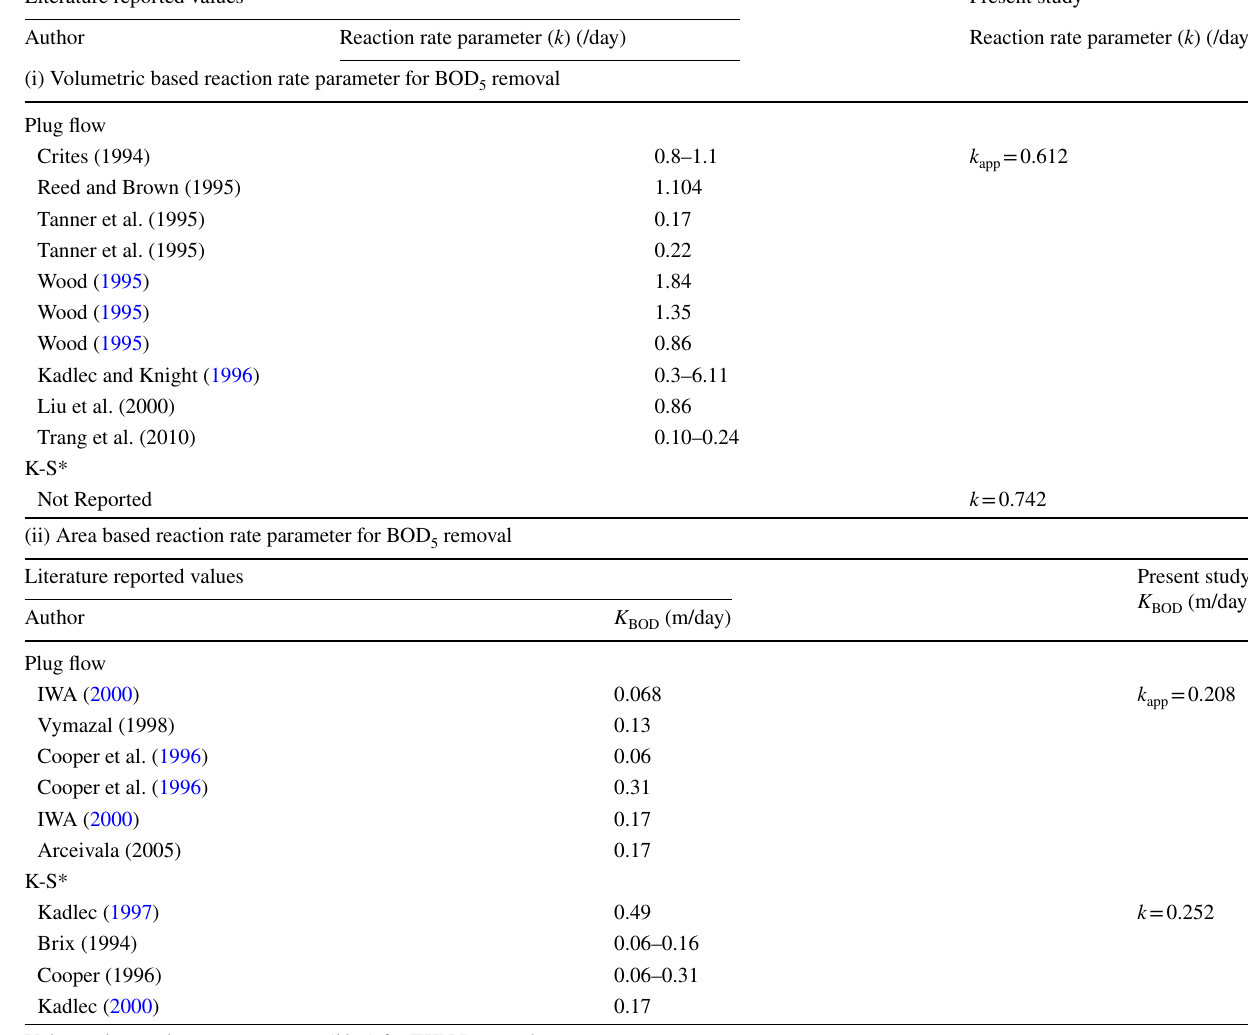
Table 7 Volumetric and area reaction rate parameter (/day) for BOD Literature reported